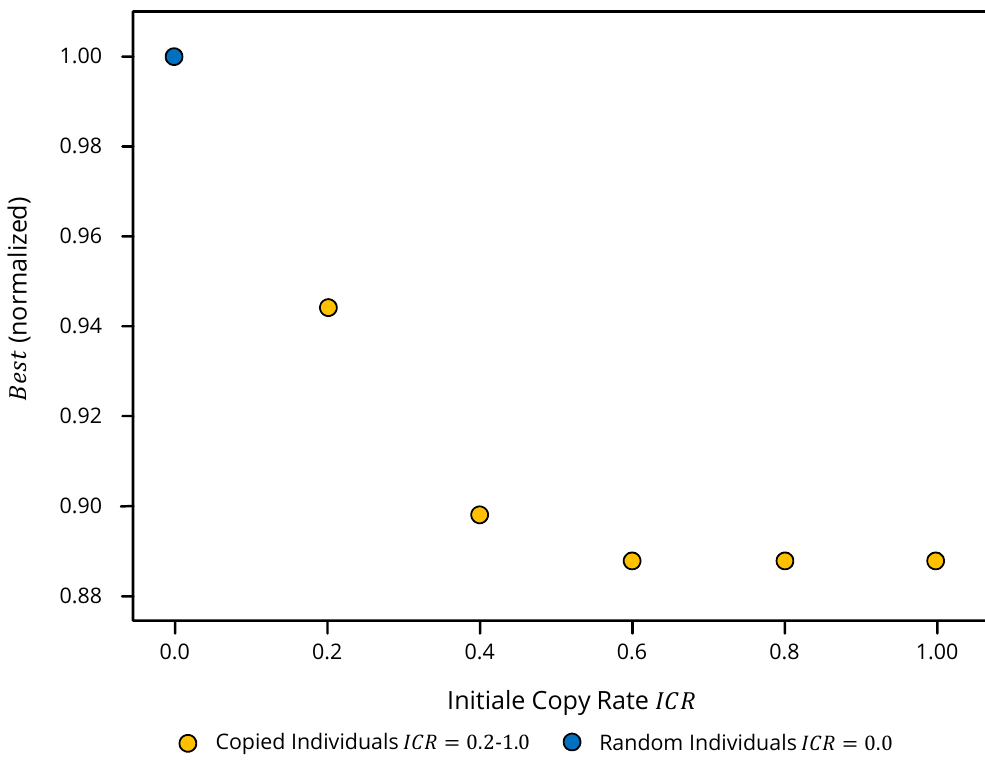
Figure 6. Example of how the initial copy rate works; worst value: Best =